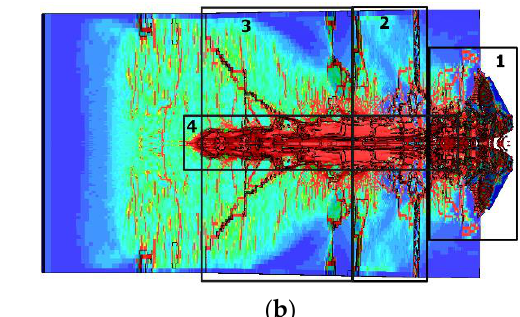
Figure 8. Internal crack of red sandstone target at impact velocity of 1107 m/s: ( a ) experimental result; ( b ) numerical simulation results.